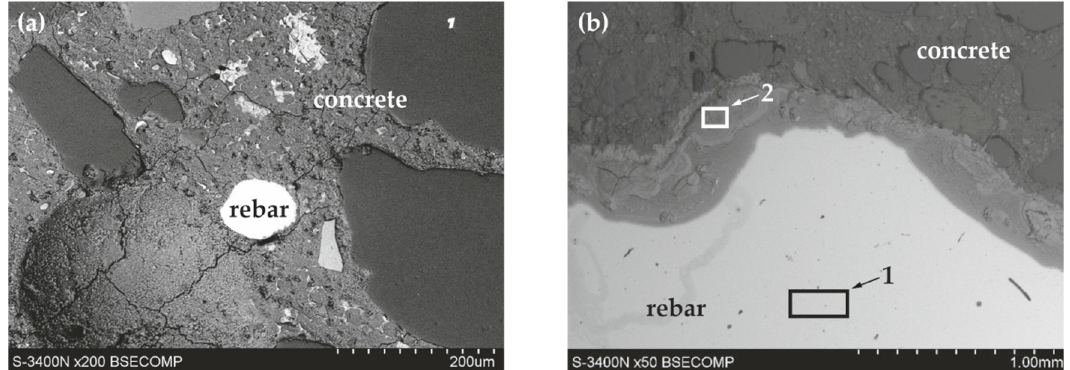
Figure 11. Microstructure of the joint between concrete without chlorides and reinforcement made of black steel B500SP (SEM): ( a ) general view of a cross-section of a steel bar in concrete ( b ) morphology of the boundary of separation rebar–concrete with marked places 1 and 2 for microanalysis of the chemical composition